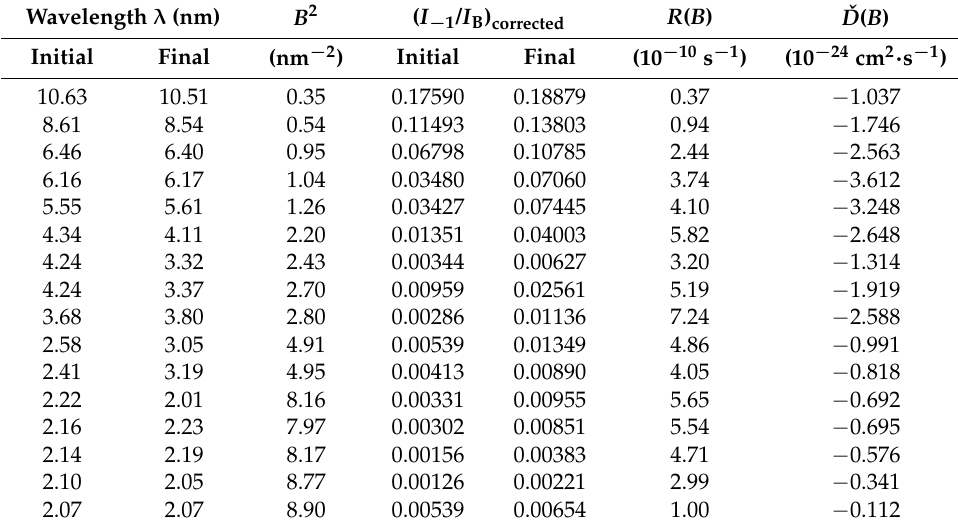
Table 1. X-ray diffraction and diffusivity measurements of Cu-Ni(Fe) at 23 °C.